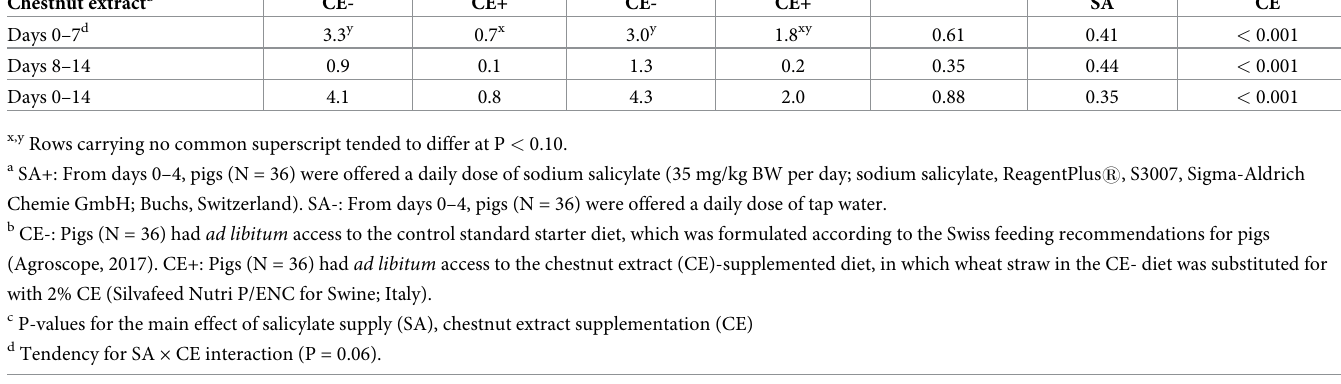
Table 3. Number of days in diarrhea (i.e., fecal score � 3) in the two weeks after infection in piglets. Salicylate a SA- SA+ SEM P-values c Chestnut extract b CE- CE+ CE- CE+ SA CE Days 0–7 d 3.3 y Days